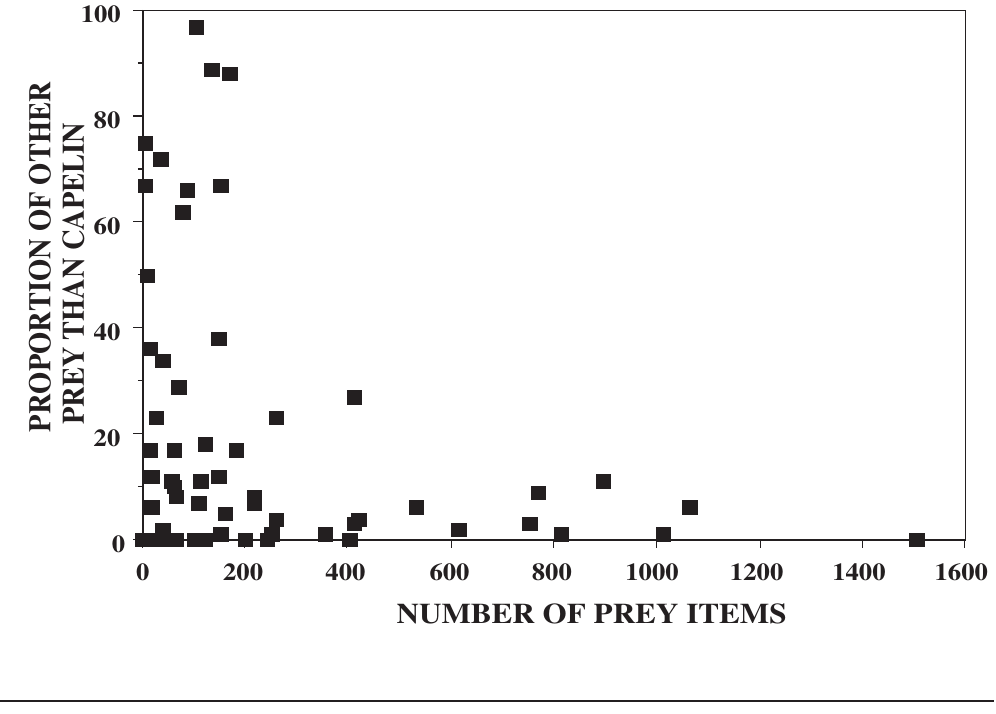
NUMBER OF PREY ITEMS